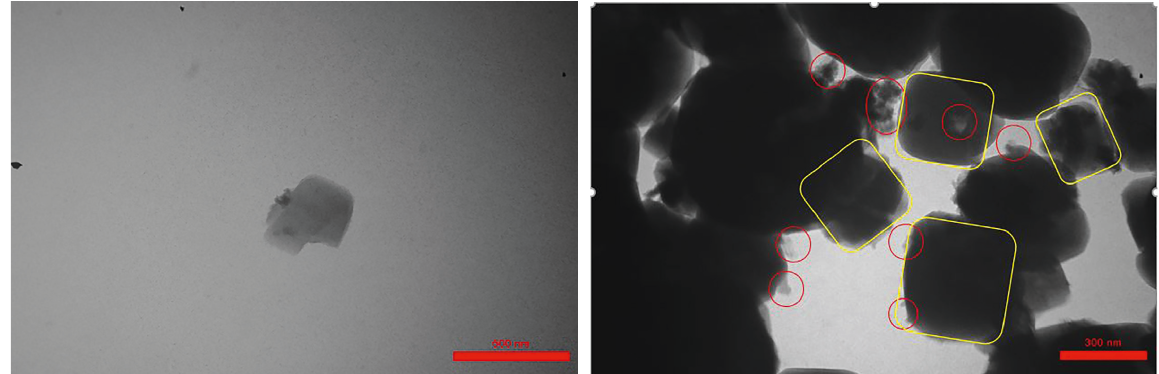
2 /4A nanoparticles: yellow cubes represent 4A zeolite and red circles represent zinc and titanium oxide